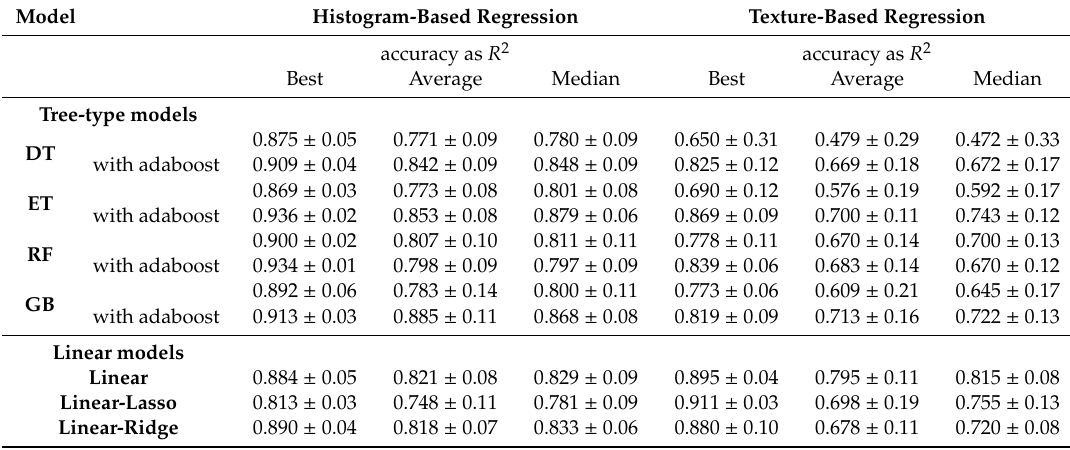
Table 2. Overview of average predictive accuracy as R 2 of the predicted fuel quality for the di ff erent methods and algorithms.